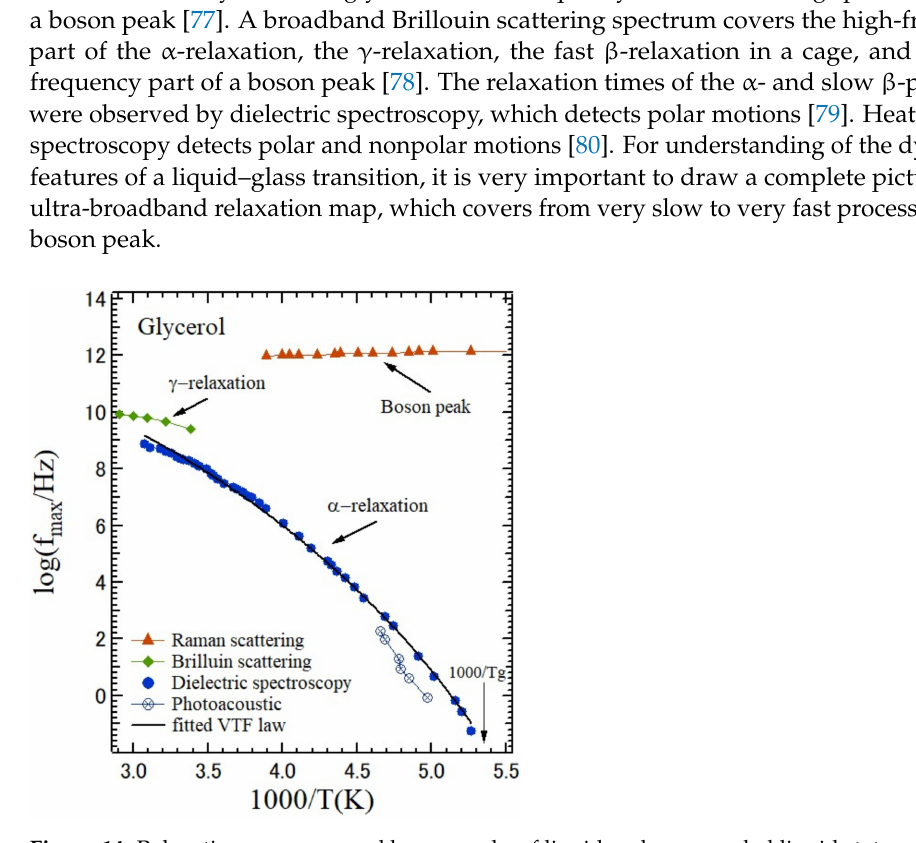
Figure 14. Relaxation processes and boson peaks of liquid and supercooled liquid states of glycerol. The main structural relaxation, α -relaxation, obeys the Vogel–Tammann–Fulcher (VTF) law [77–80]. The polarized and depolarized broadband spectra between 1 GHz and 10 THz mea- sured by a tandem multi-pass FPI and a Raman spectrometer were studied in silica,